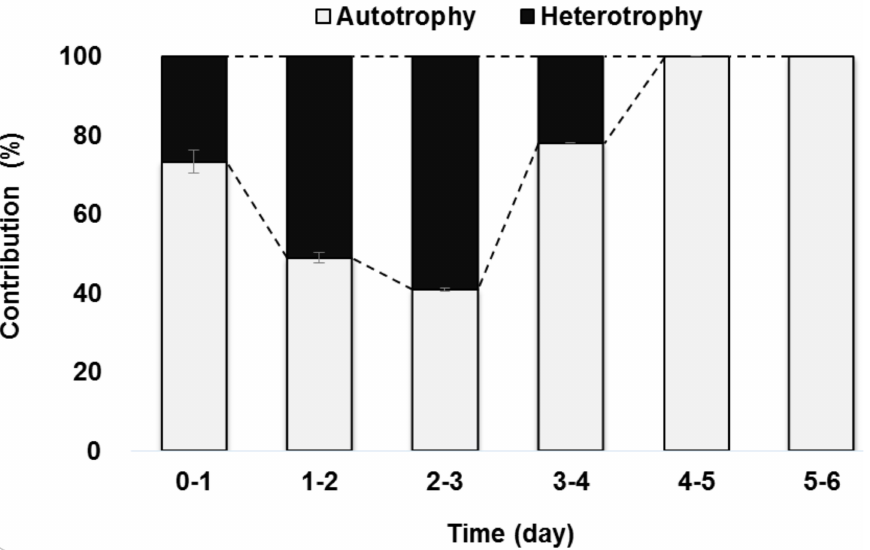
Figure 2. Variations in the contribution ratio of autotrophic and heterotrophic metabolism during six days of the mixotrophic culture. Artificial wastewater was prepared in a modified BG11 medium with NaHCO 3 0.5 g-C L − 1 and glucose 0.5 g-C L − 1 . The contribution ratio of autotrophic and heterotrophic metabolism was calculated based on the amount of consumed NaHCO 3 and glucose,